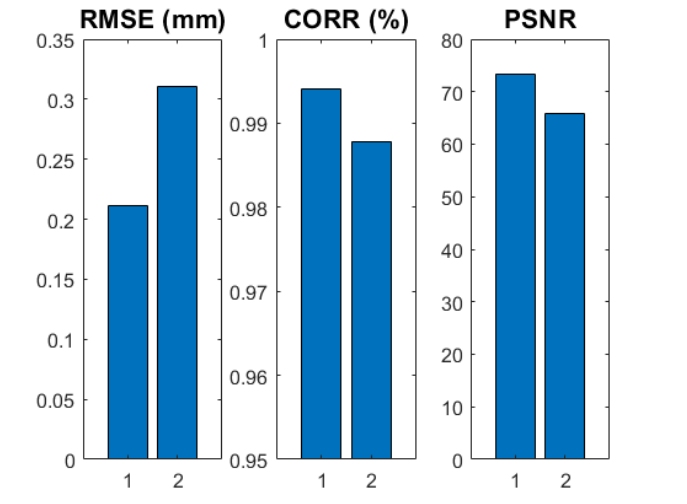
Figure 9. Analytical results of average of 10 comparison measurements between the stationary SFF measurement (1), the scanning SFF measurement (2) and the ground truth.